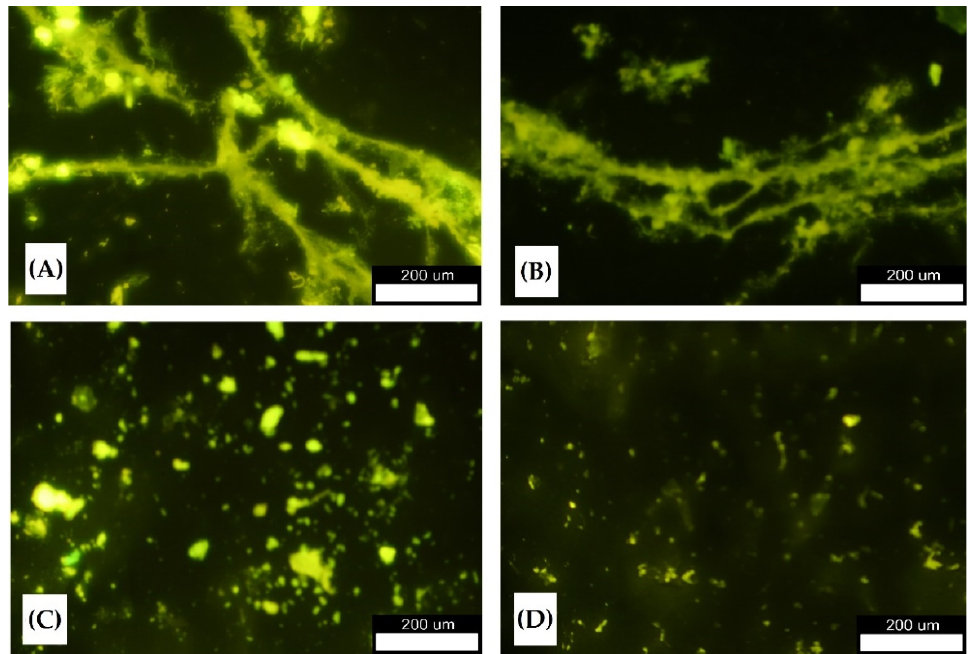
Figure 6. Representative images of lysozyme fibrils produced by ThT staining under the fluores- cence microscope after the application of AMF for 15 min: ( A ) pure preformed fibrils without MN, ( B ) fibrils with 0.5 mg/mL of MN, ( C ) fibrils with 0.9 mg/mL of MN, and ( D ) fibrils with 1.3 mg/mL of MN. Scale bars: 200 μ m.